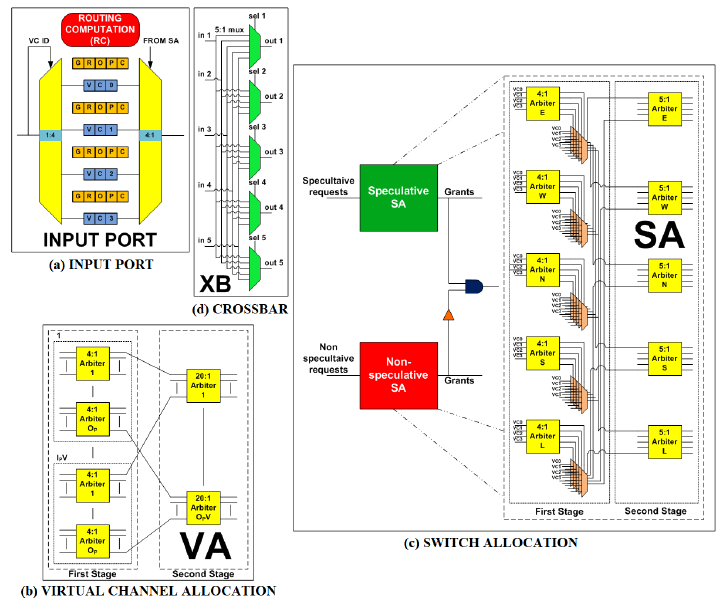
Figure 2. Components of the